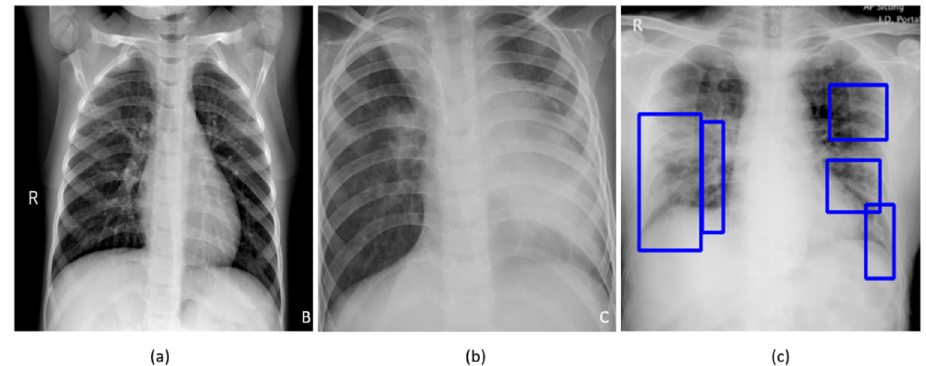
Figure 1. Chest X-rays (CXRs) showing ( a ) clear lungs; ( b ) bacterial pneumonia infection manifesting as consolidations in the right upper lobe and retro-cardiac left lower lobe; and ( c ) COVID-19 pneumonia infection showing bilateral manifestations. Blue frames in ( c ) denote radiologist annotations indicating disease regions, which serve as ground truth in our analysis.